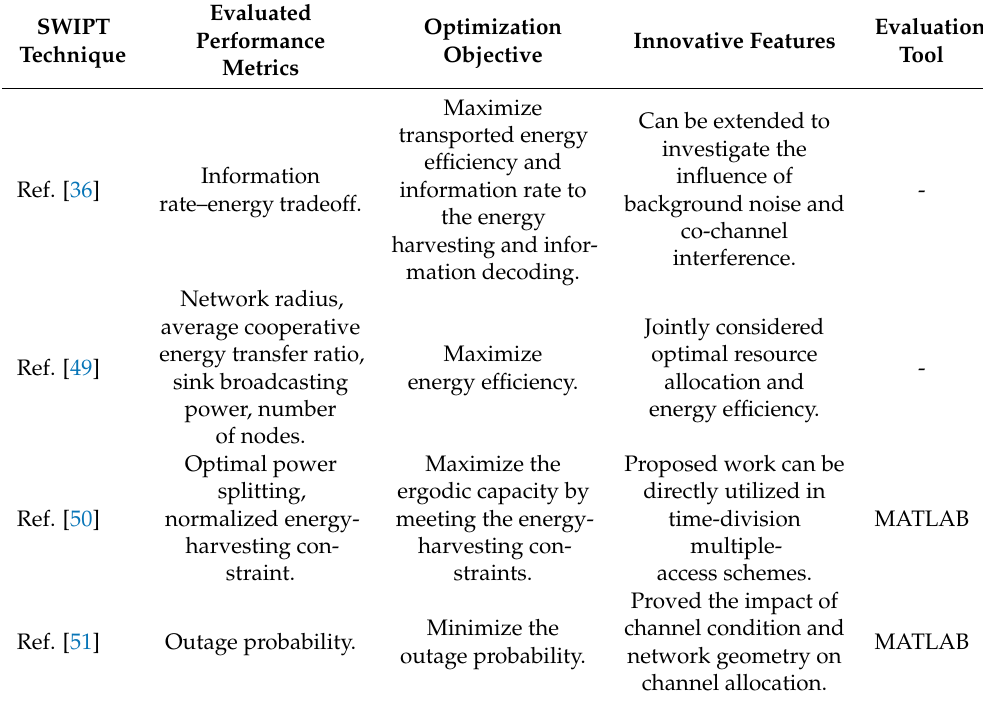
Table 8. Comparison of existing SWIPT techniques in terms of the evaluated performance metrics, objective, and outstanding